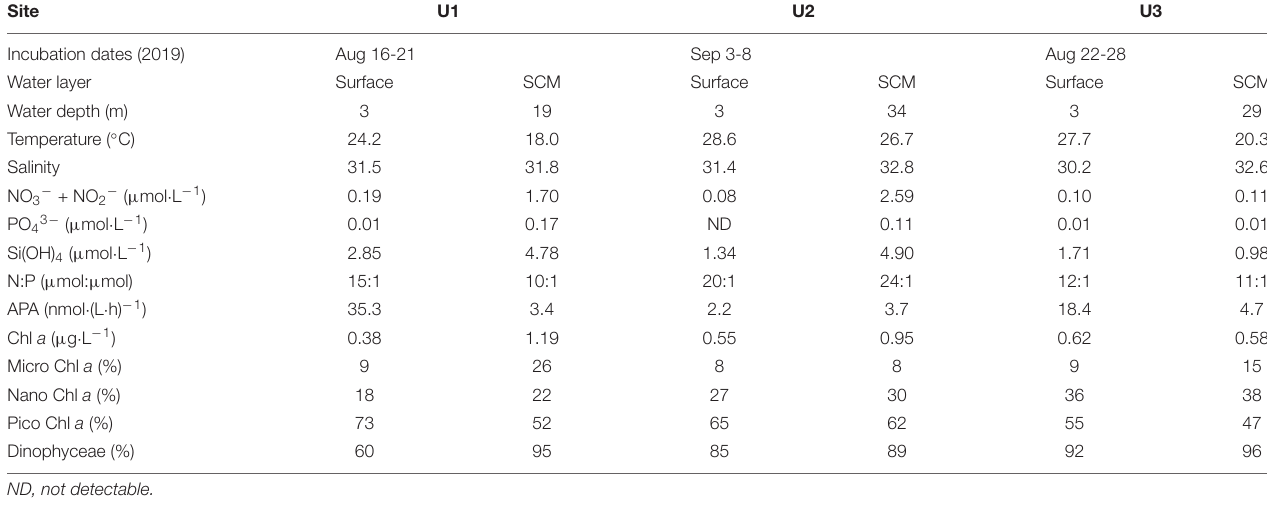
TABLE 2 | Background conditions of seawater at the experimental sites.